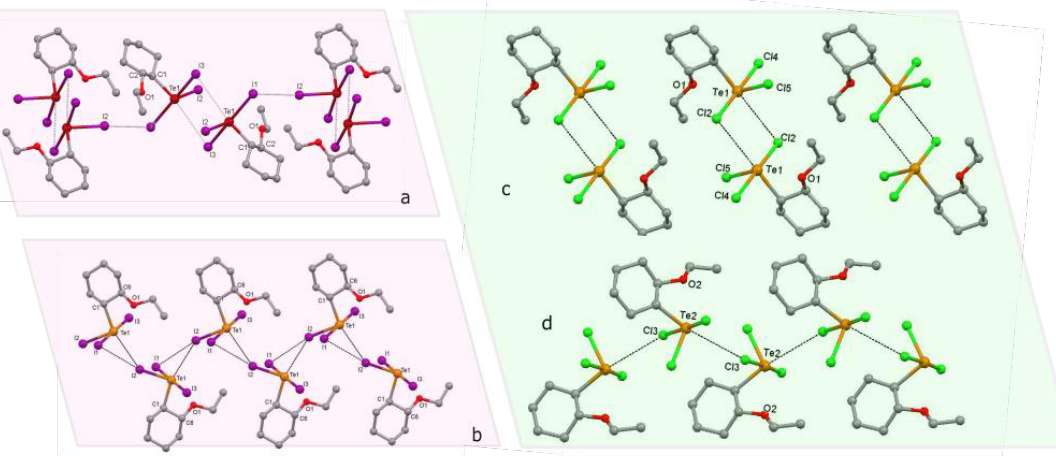
Figure 5. Fragment of packing of 5a ( a ), 5b ( b ) and C 6 H 10 (OEt)TeCl 3 (WEQTUH ( c , d ) showing the Te—X ChB stabilized centrosymmetric dimers in in 5a ( a ) and C 6 H 10 (OEt)TeCl 3 ( c ); and Te—X ChB stabilized catemer chain in 5b ( a ) and C 6 H 10 (OEt)TeCl 3 ( d ). Hydrogen atoms are omitted for clarity. Selected distances (Ǻ) in 5a ( a ): (intramolecular) O1-Te1 2.796(4), I2-Te1 2.7243(5), I1-Te1 2.9664(5), I3-Te1 2.8520(5); (intermolecular); Te1-I3 3.9199(6); Selected distances (Ǻ) in 5b ( b ): (intramolecular) I2-Te1 2.699(1), Te1-I3 2.717(2), Te1 I1 2.869(1), Te1 O1 2.775(9); (intermolecular); Te1-I2 3.902(1), I1-I2 3.493(2).